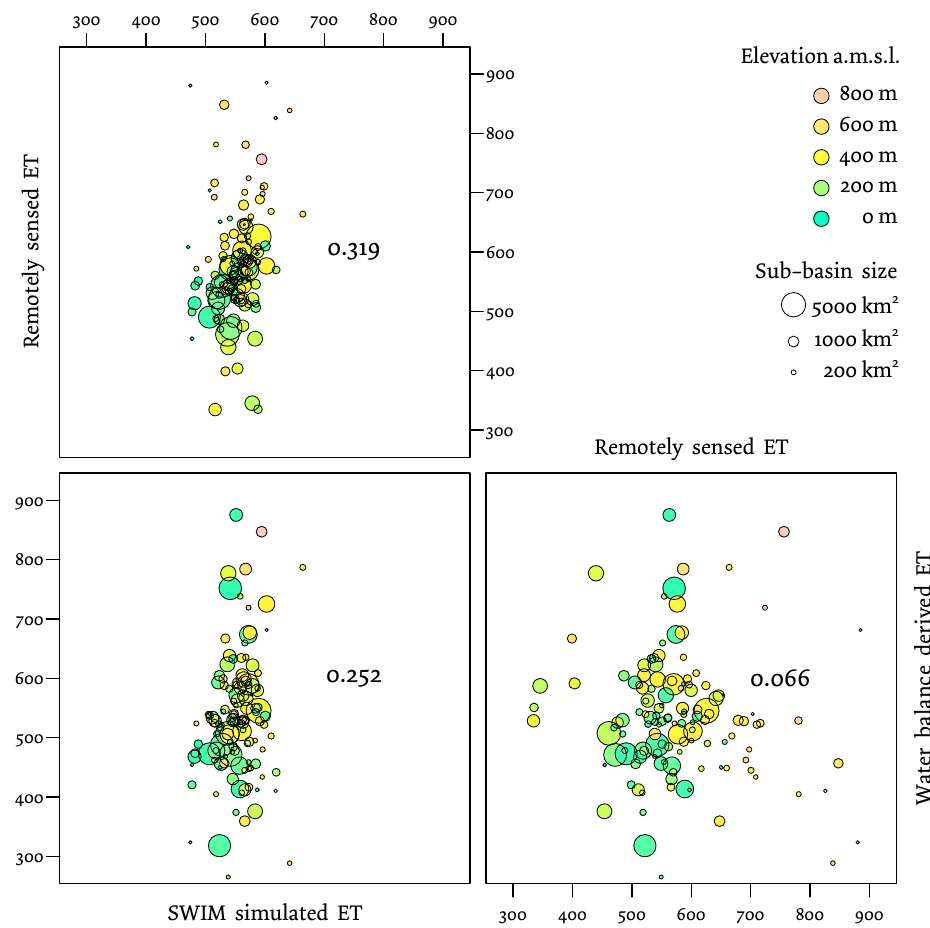
Fig. 12. Correlations between remotely sensed, SWIM simulated, and water balance derived evapotranspiration in mma − 1 .